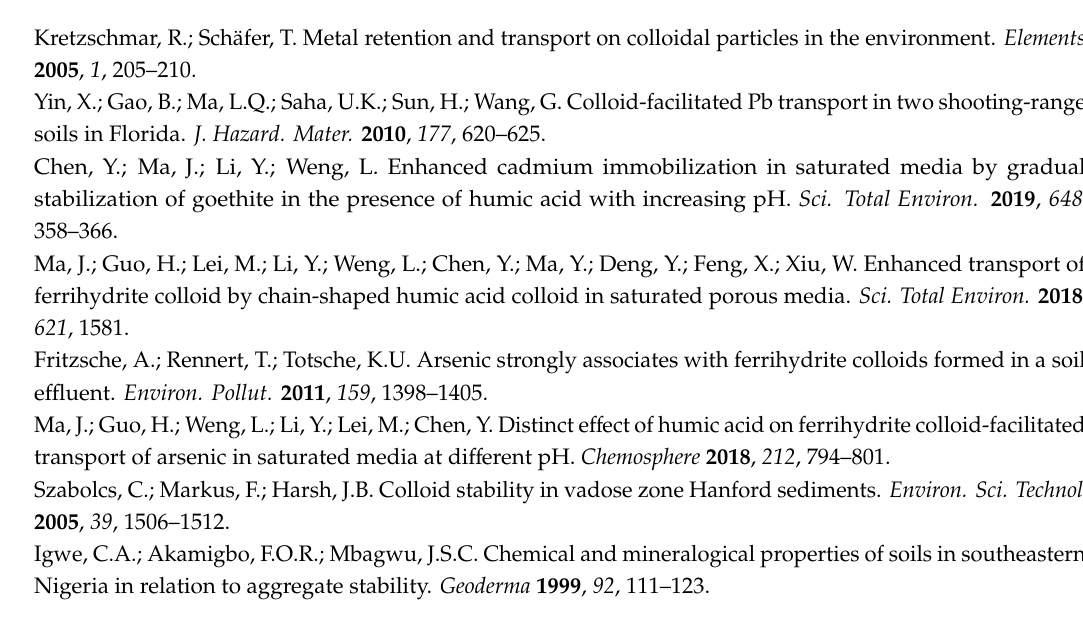
parameters of transport experiments (Table S3: Fitted and experimental parameters of transport of soil colloids in the sand, 0.5% GT mixed sand, and 0.5% GT-0.2% HA sand columns at pH 7.0.), S6: The DLVO energy barriers for settling and transport systems (Table S4: The DLVO energy barriers for settling systems. Table S5: The primary energy barriers for transport